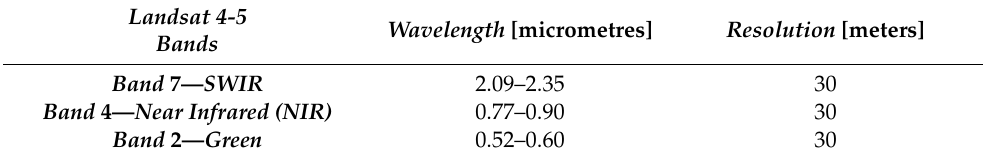
Table 2. Band composition chosen to combine the satellite images referring to the Landsat 4-5